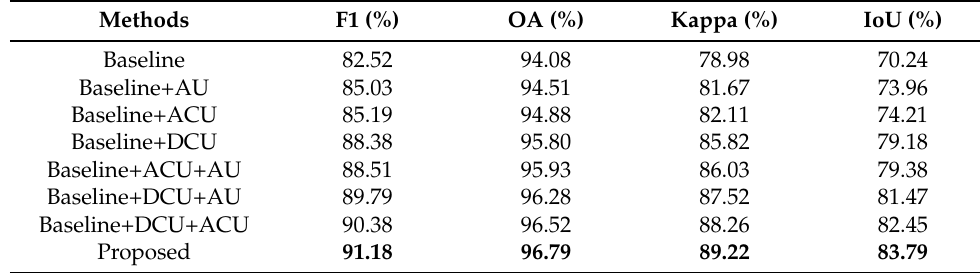
Table 4. Ablation study on the proposed CD network. The best values are in bold.